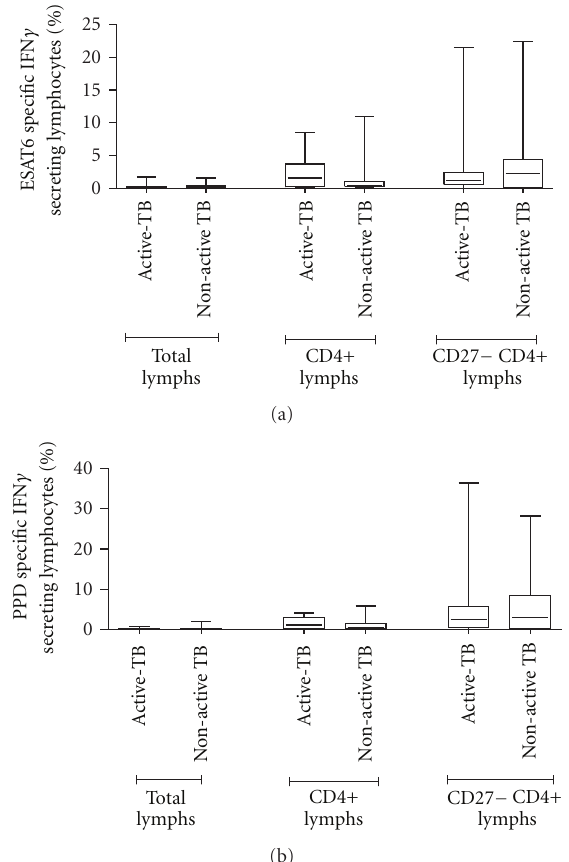
Figure 5: ESAT6 (a) and PPD-specific (b) IFN γ secreting total, CD4+ and CD27 − CD4+ memory blood T lymphocytes in active and non-active TB groups. No statistical di ff erences were noted between the two TB groups for any of the lymphocyte populations analyzed. Blood, n =